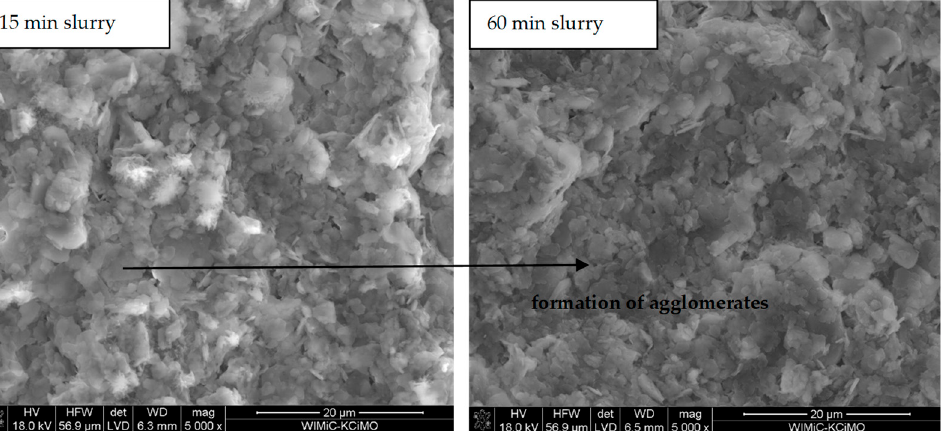
Figure 12. SEM microphotographs of clay–cement slurry prepared on a kaolinite clay base with 10% cement addition [46].